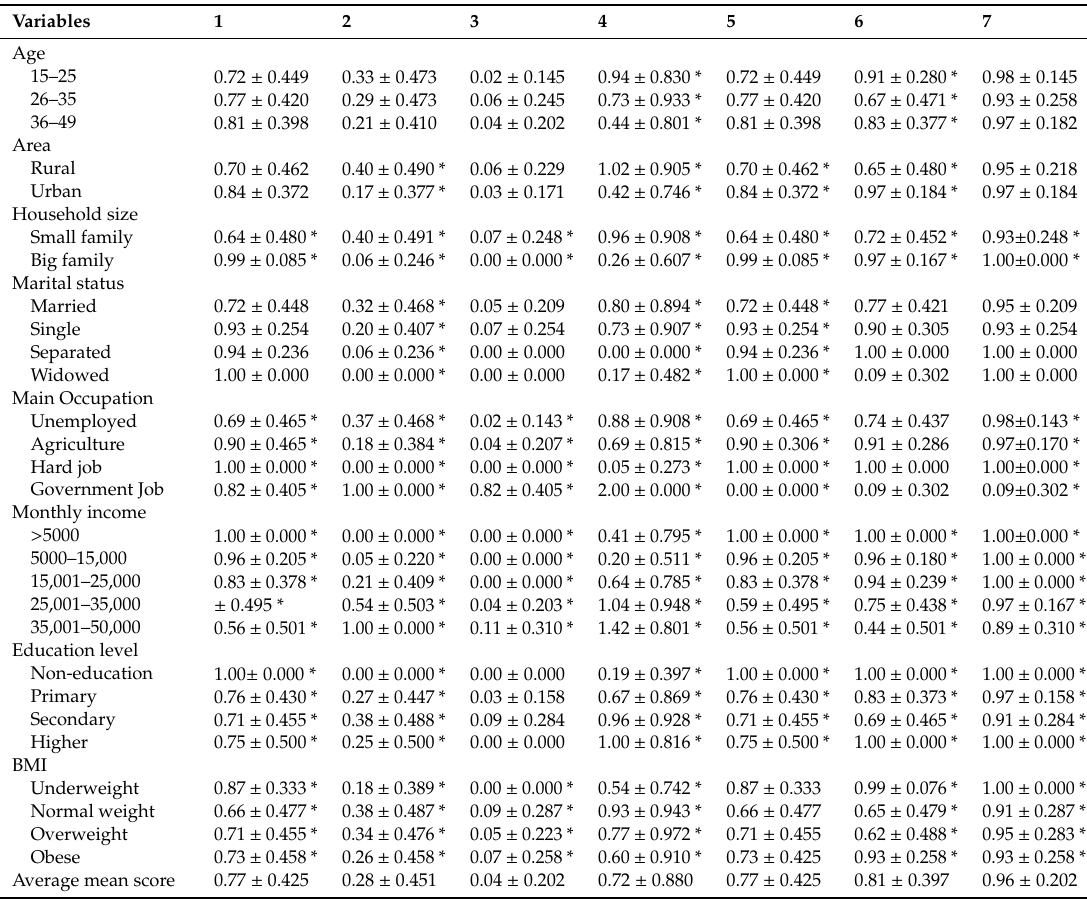
Table 3. Each dimension of the average score indi ff erence (knowledge) variables (Mean, SD) ( N = 400).